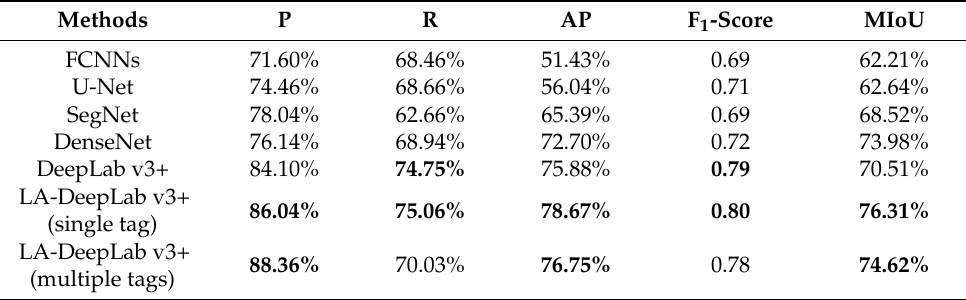
Table 1. Segmentation results of the different methods.